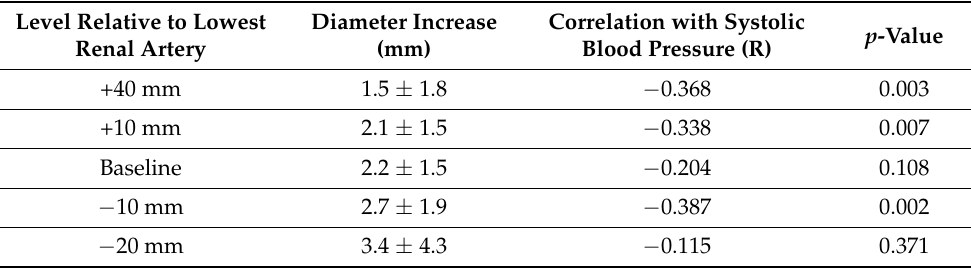
Table 4. Correlation between preoperative systolic blood pressure and aortic diameter increase